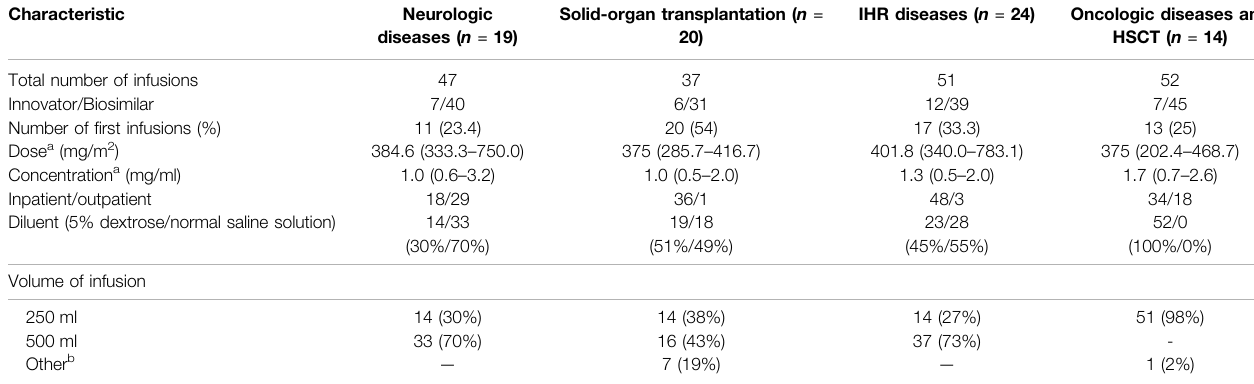
TABLE 3 | Characteristics of rituximab infusions.